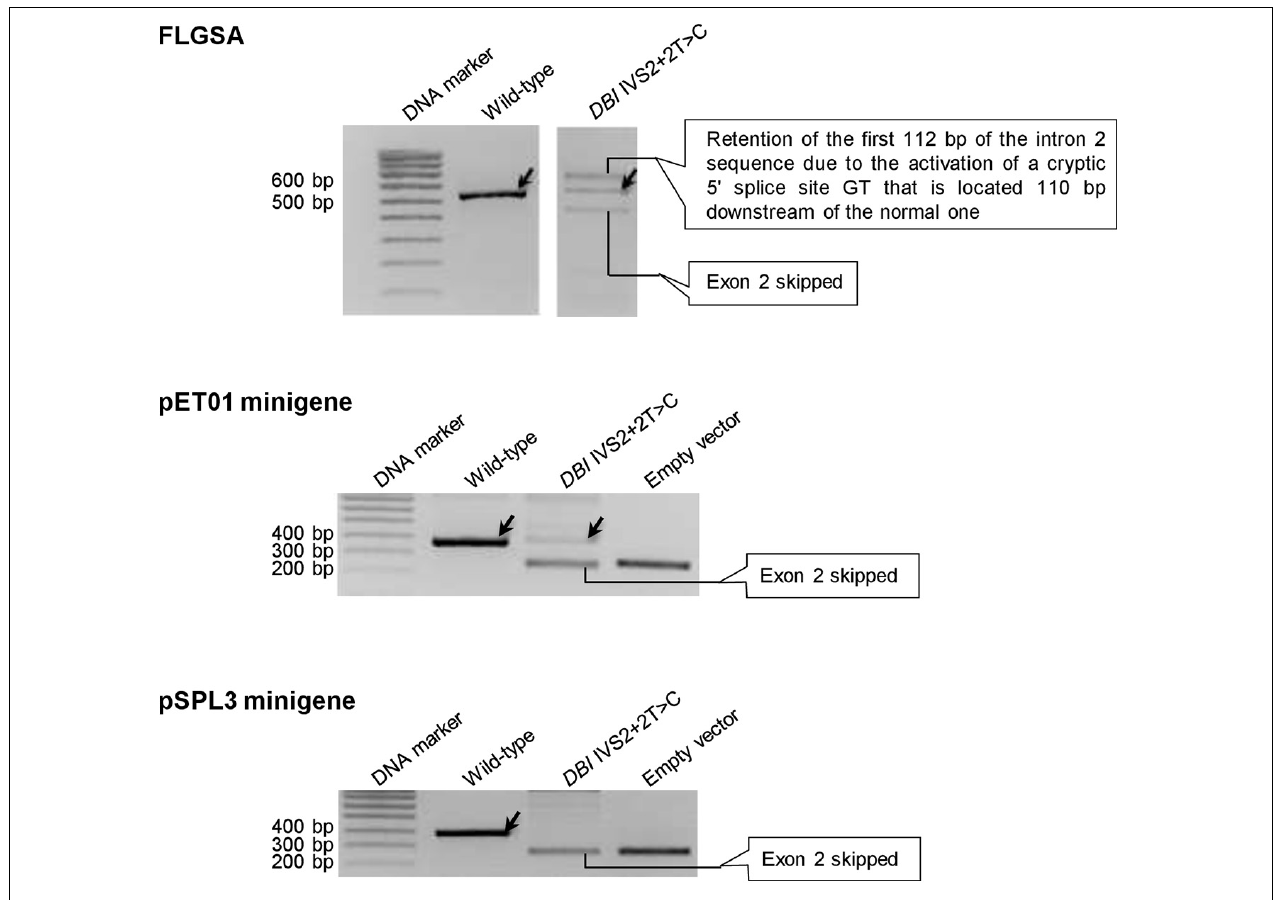
FIGURE 4 | Reverse transcription-polymerase chain reaction (RT-PCR) results from the pET01 and pSPL3 minigene assays with respect to the DBI IVS2+2T > C variant. Results from the previously performed full-length gene splicing assay (FLGSA) (Lin et al., 2019) are included for the sake of comparison (NB. The two aberrant transcripts were newly sequenced in this study). In all panels, wild-type transcripts are indicated by oblique downward pointing arrows. See Supplementary Figure 3 for the full gel photographs with respect to the minigene assays. The FLGSA data were adapted from Lin et al. (2019) with